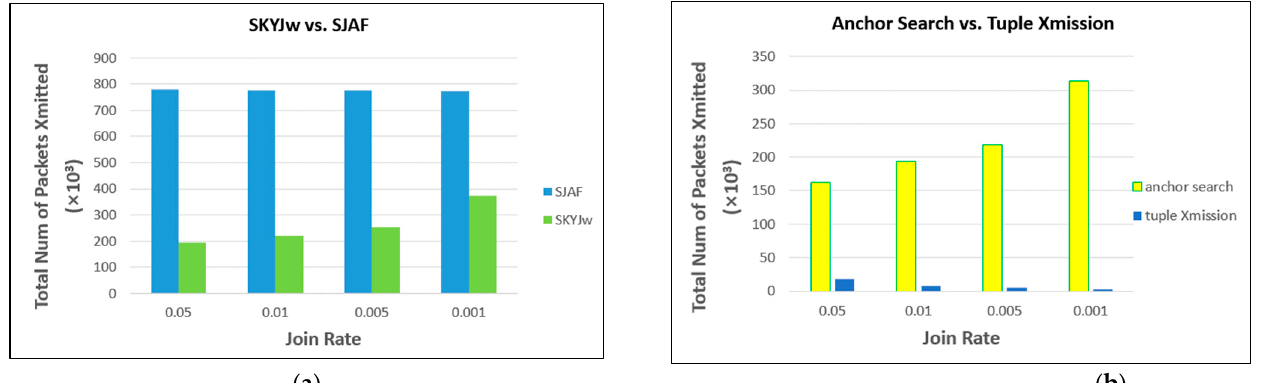
Figure 15. ( a ) Comparison between SKYJw and SJAF as the join rate varies from 0.5 to 0.001. ( b ) The cost for finding the anchor points and that of tuple transmission as the join rate varies as in ( a ).